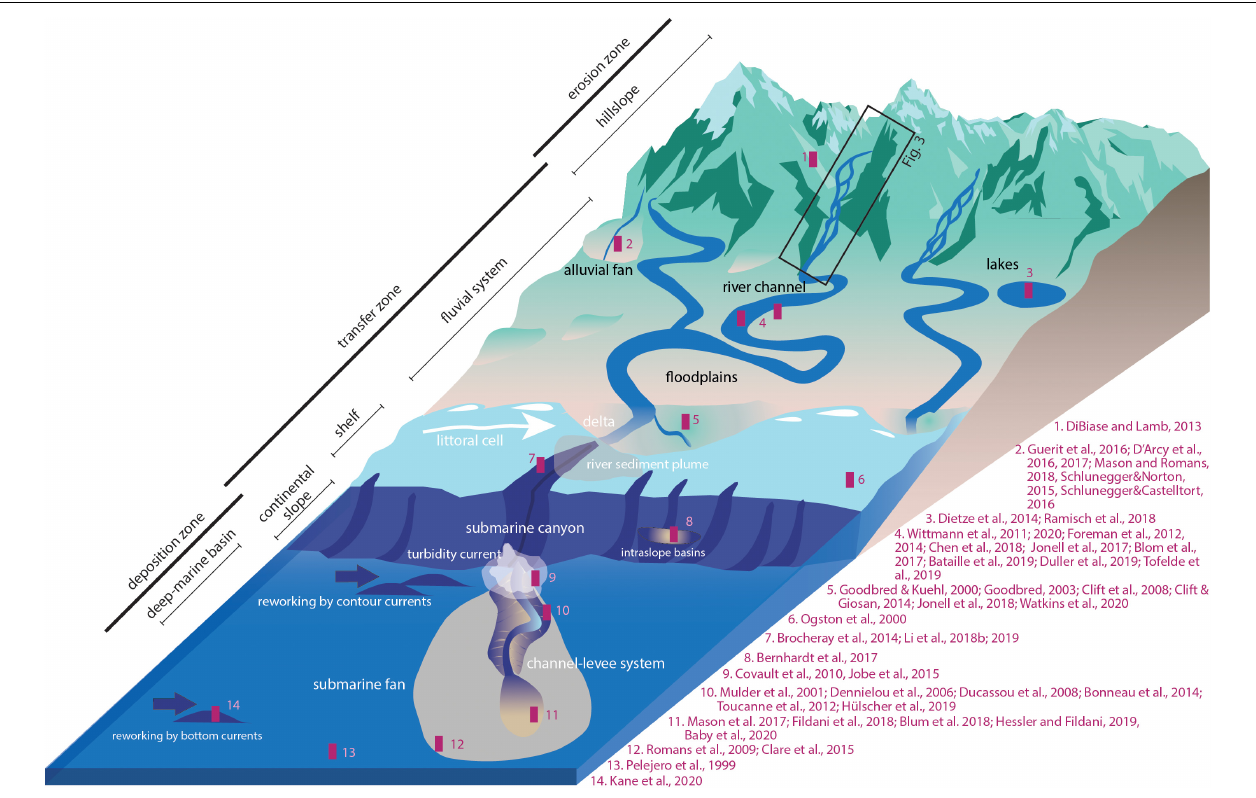
FIGURE 1 | Schematic sketch of a continental-scale sediment routing system (SRS) from the upland source to the deep-marine sink. SRSs are typically subdivided in a zone of erosion, sediment transfer, and sediment deposition. On a continental scale, SRSs comprise five landscape segments including hillslopes, fluvial system, shelf, continental slope, and deep marine basins. Sampling sites of sediment archives discussed in the text are indicated with magenta colored symbols. The studies referred to here are not exhaustive; please see the text for additional references. Black frame marks the erosion zone as discussed in Figure 3